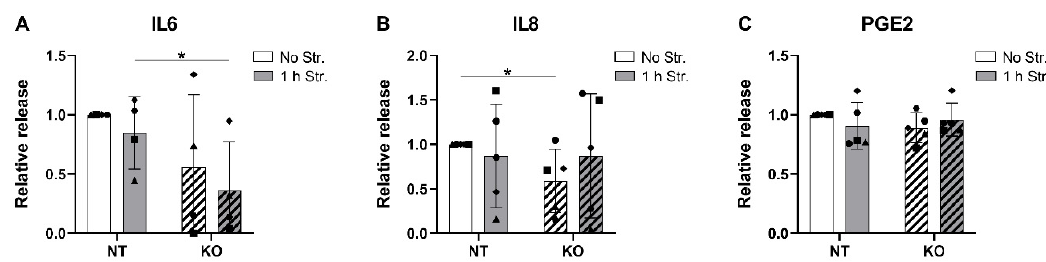
Figure 7. Relative release of ( A ) IL6; ( B ) IL8; and ( C ) PGE2 in the CRISPR-Cas9-transduced non-targeting control (NT, non-hatched bars) and the TRPV4 knockout (KO, hatched bars) cells 24 h after no (white bars) or 1 h (grey bars) of cyclic stretching at 20% strain and 1 Hz. n = 4–5 donors; mean ± SD; * p < 0.05.